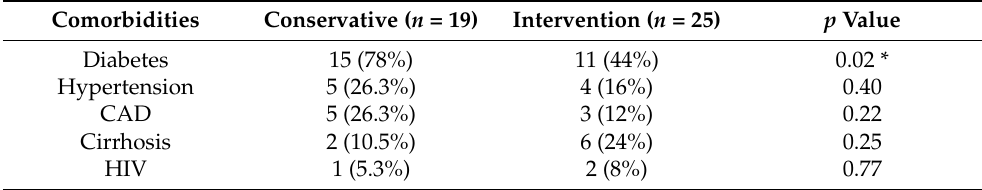
Table 2. Comorbidities of the two study groups.